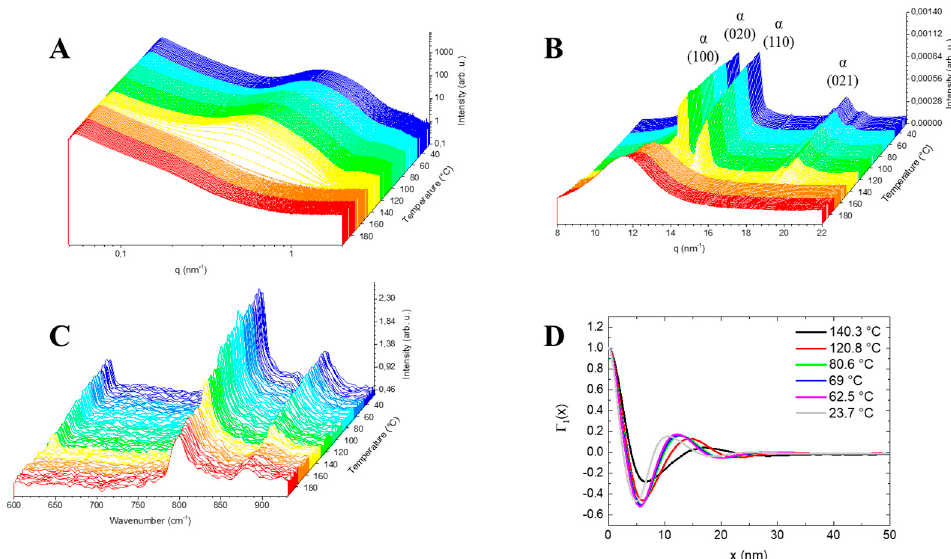
Figure 5. Three-dimensional plots of the time-resolved SAXS ( A ) and WAXS ( B ) pattern (100), (020), (110) and (021) (hkl) planes of the monoclinic PVDF phase (pseudo-orthorhombic) [81] and Raman spectra ( C ), obtained using in situ Raman spectroscopy combined with SAXS/WAXS coupled to a Linkam DSC setup, during the cooling step from the melt to room temperature (RT) of the blend PVDF/fluoroelastomer sample. ( D ) Correlation function derived from the SAXS data of the PVDF blend derivative upon